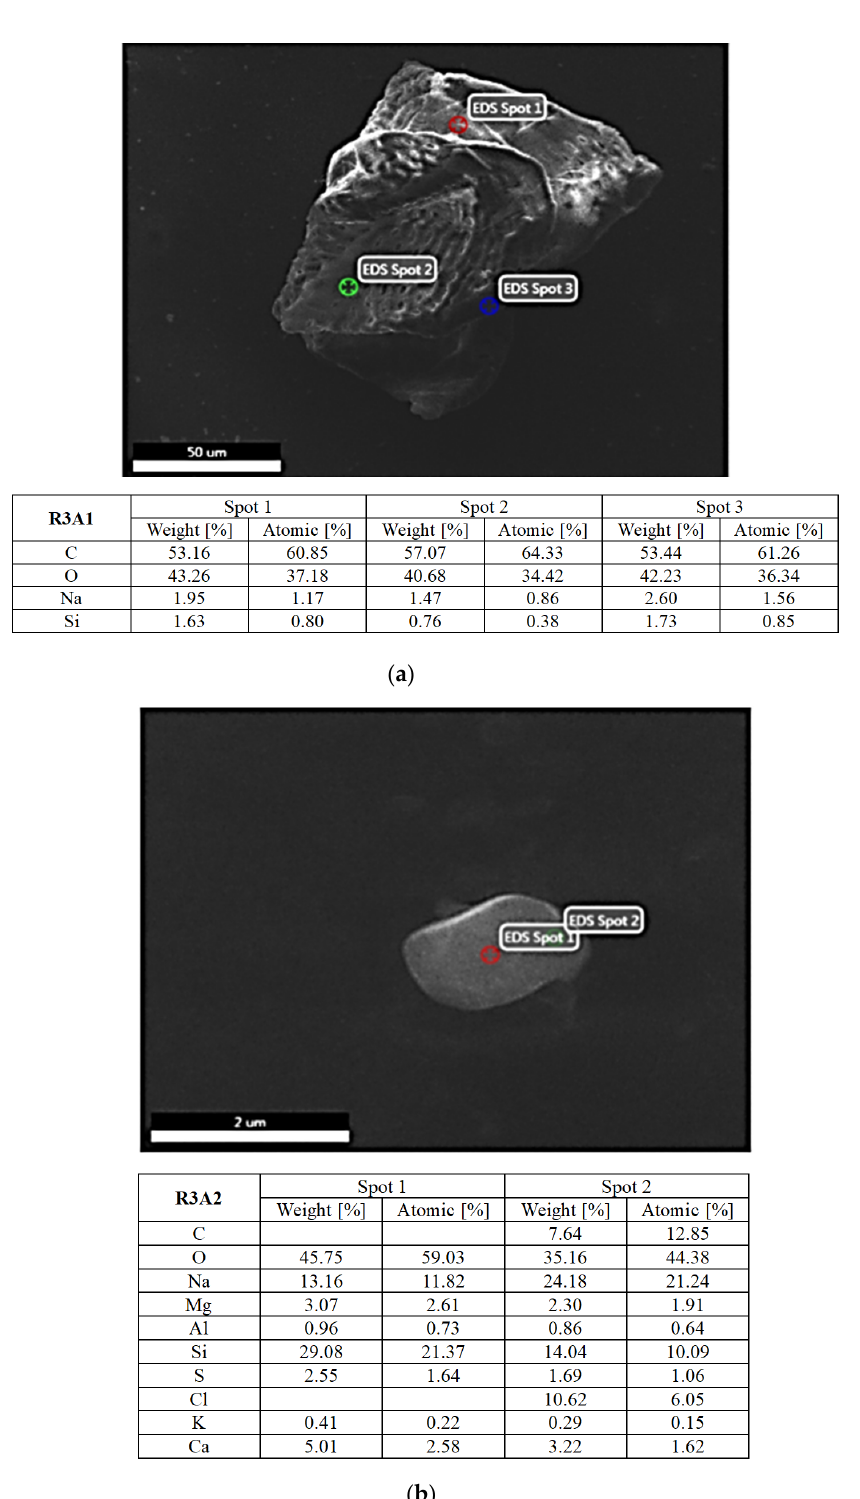
Figure 8. Report 2 of SEM-EDS results of analyzed areas of dry material decanted from rainwater: